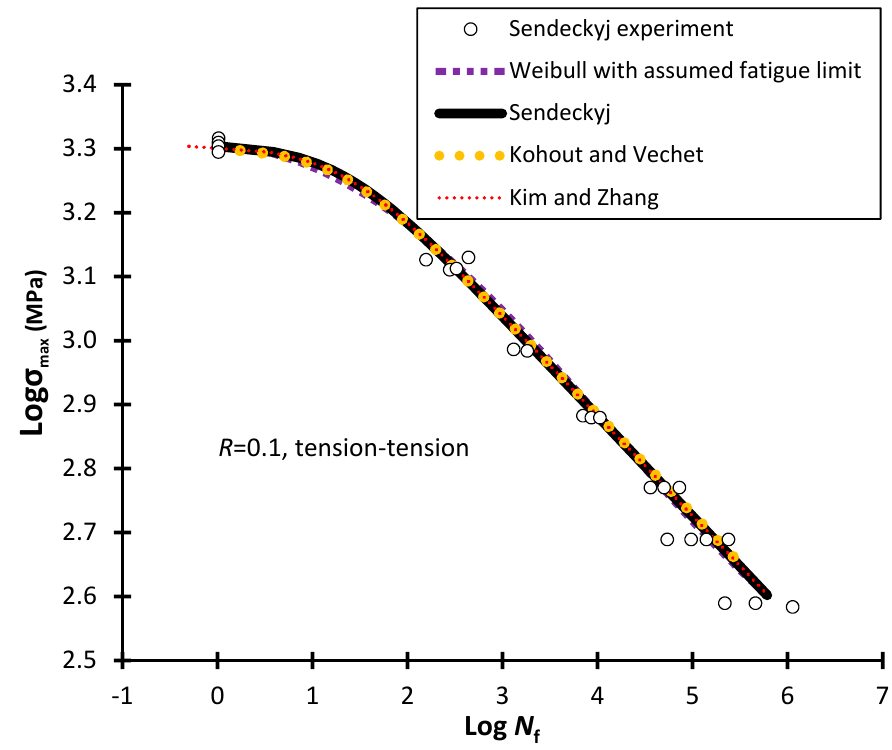
Figure 6. Sendeckyj experimental data at R = 0.1 [19] for T-T loading with S-N curves obtained from: Weibull model with α = 0.088 and β = 1.9 for assumed σ ∞ = 250 MPa; Sendeckyj model with α = 0.0485 and β = 0.157; Kohout and Vechet model with α = 19.953 and β = − 0.155; and Kim and Zhang model with α = 3.13 × 10 − 27 , β = 7.381 for N 0 = 0.5.